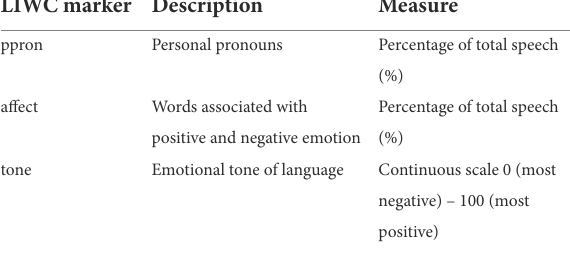
TABLE 2 The three lexical markers used for